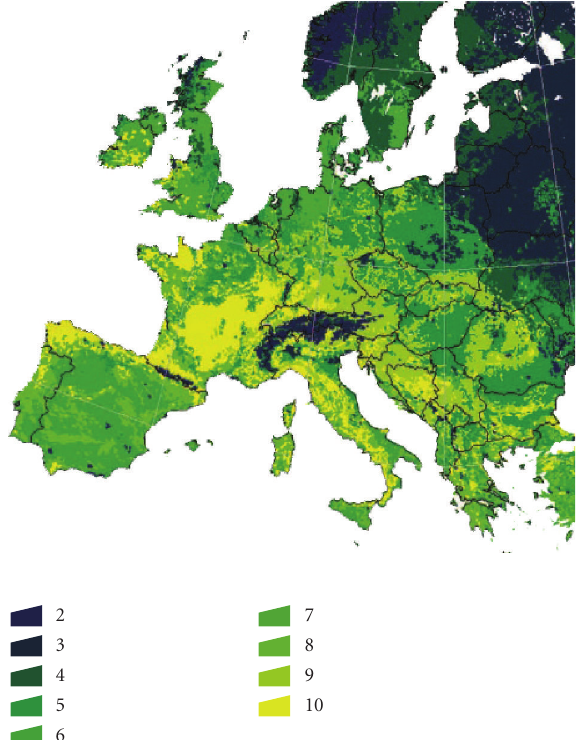
Figure 3: The vegetation-derived clusters as recognized over the western Palaearctic. The image was obtained from a yearly series of monthly satellite images, capturing the Normalized Di ff erence Vegetation Index (NDVI): a measure of the photosynthetic activity of the vegetation. These images were subjected to a cluster analysis according to the monthly NDVI features to obtain 10 categories (category 1 is water and not displayed in the picture). (Estrada- Pe˜na et al. 2006 [48], with permission from Medical and Veterinary Entomology